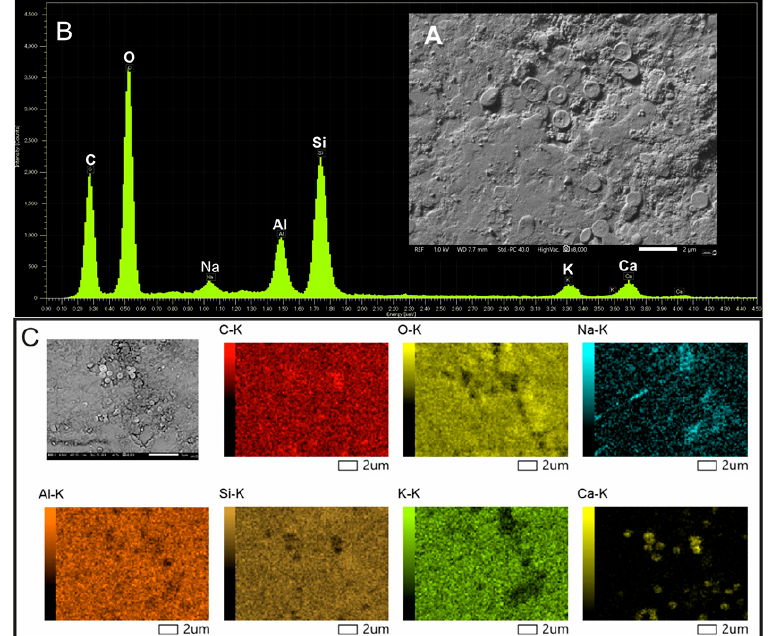
Figure 6. (A) Disk-shaped calcite crystals on the microcline surface, (B) Chemical composition of “A” Figure 6. ( A ) Disk-shaped calcite crystals on the microcline surface, ( B ) Chemical composition of “A” surface area determined by EDS, (C) Element mapping of the “A” surface area. surface area determined by EDS, ( C ) Element mapping of the “A” surface